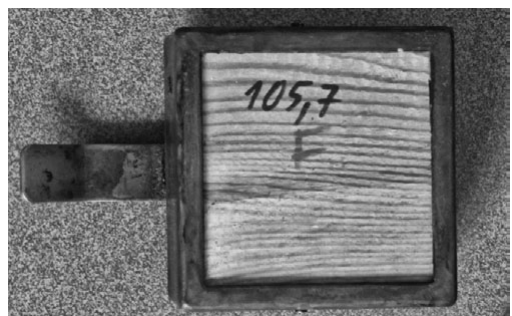
Fig. 2. Pine timber specimen prepared for experimentation